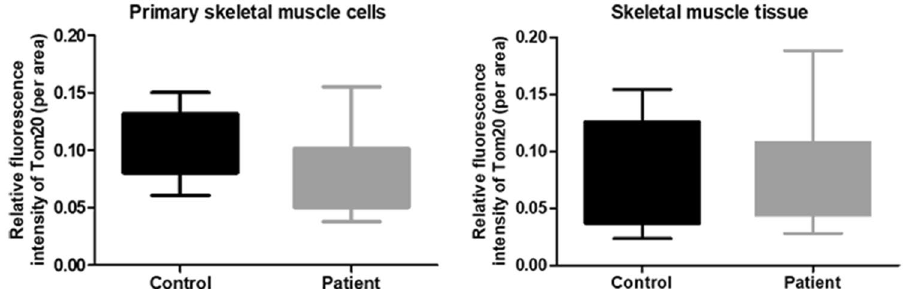
Figure 7. Fluorescence intensity analysis of TOM20 in primary skeletal muscle cells and skeletal muscle tissue sections of Megaconial CMD patient. Intensity quantifications were performed on 30 primary skeletal muscle cells and skeletal muscle tissue fibers in both patient and control